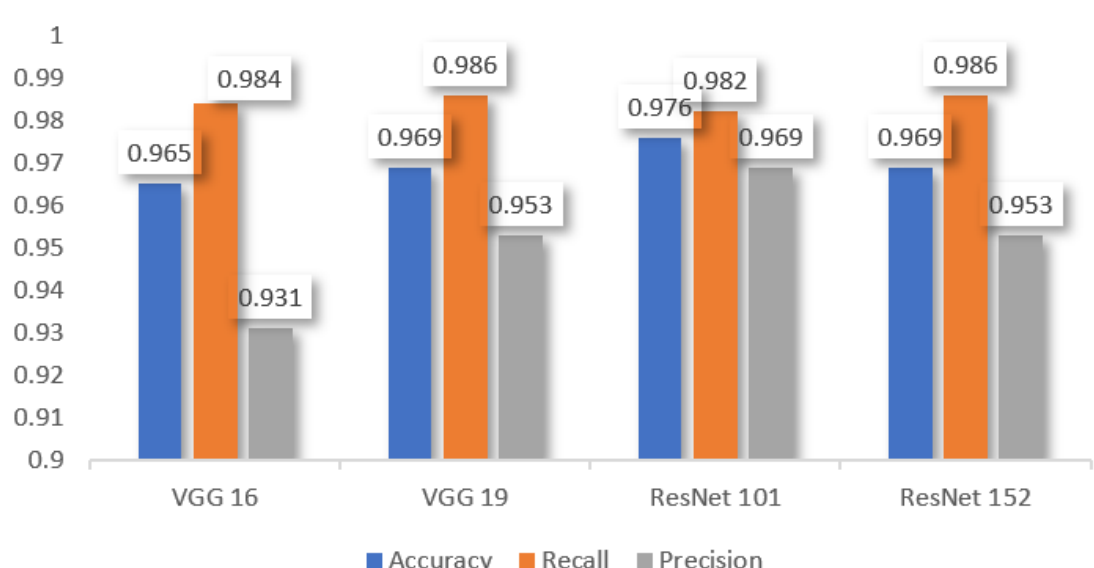
Figure 13. Comparative analysis of the performance metrics among various models using Gaussian algorithm.